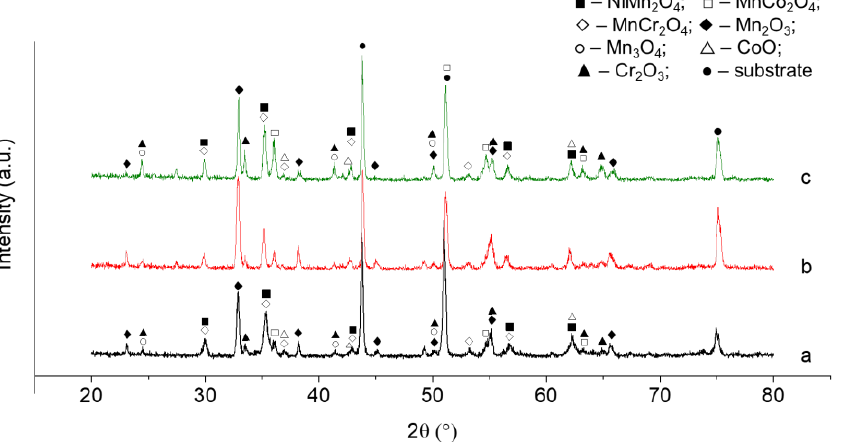
Figure 7. XRD patterns of samples before the heat resistance test ( a ) and after 50 ( b ) and 100 ( c ) hours of exposure in air atmosphere. The following PDF2 cards were used: NiMn 2 O 4 — 00-084-0542; MnCo 2 O 4 — 00-084-0482; MnCr 2 O 4 — 00-075-1614; Mn 2 O 3 — 00-073-1826; Mn 3 O 4 — 00-075-1560; CoO — 00-075-0418; Cr 2 O 3 — 00-082-1484.